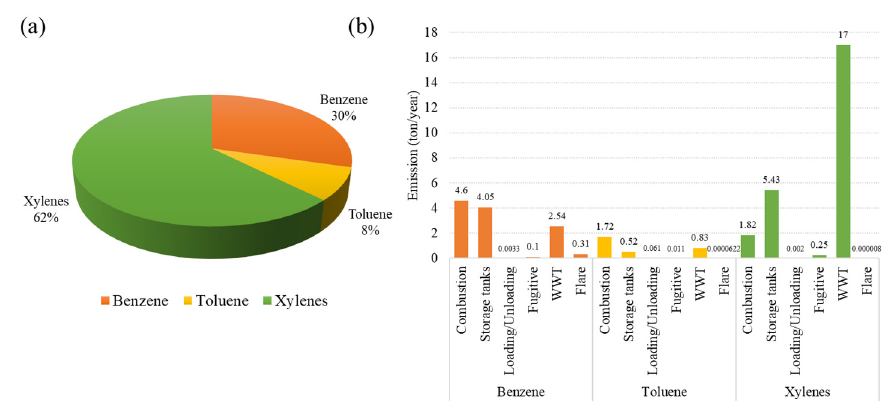
Figure 3. ( a ) VOCs (BTX) emission contribution from the petrochemical industry; ( b ) source contribution to the VOCs (BTX) from the petrochemical industry.